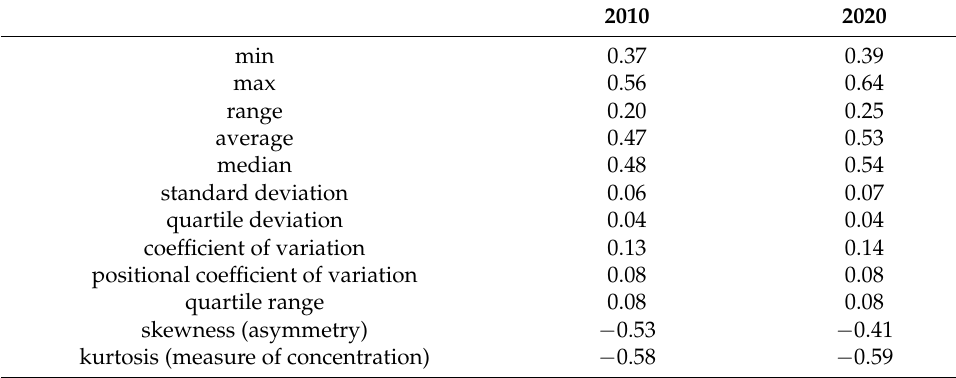
Table 4. Measures differentiating the synthetic measure of the quality of life in voivodships in Poland in 2010 and 2020.